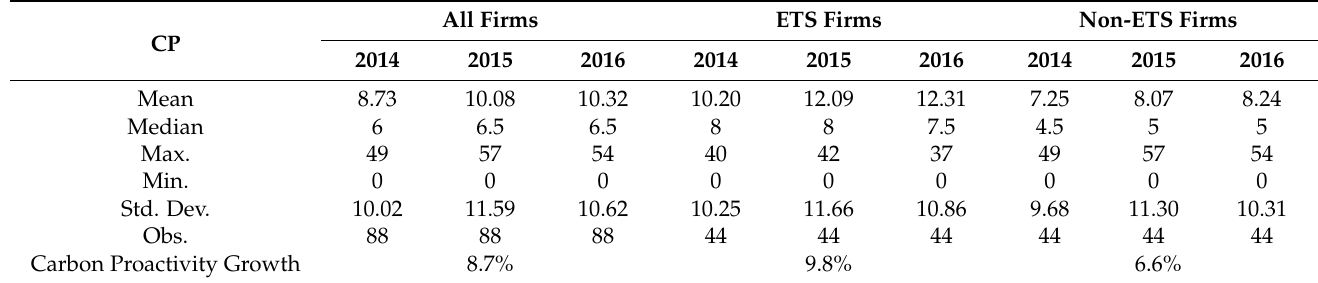
Table 8. Descriptive Statistics of Carbon Proactivity by Calendar